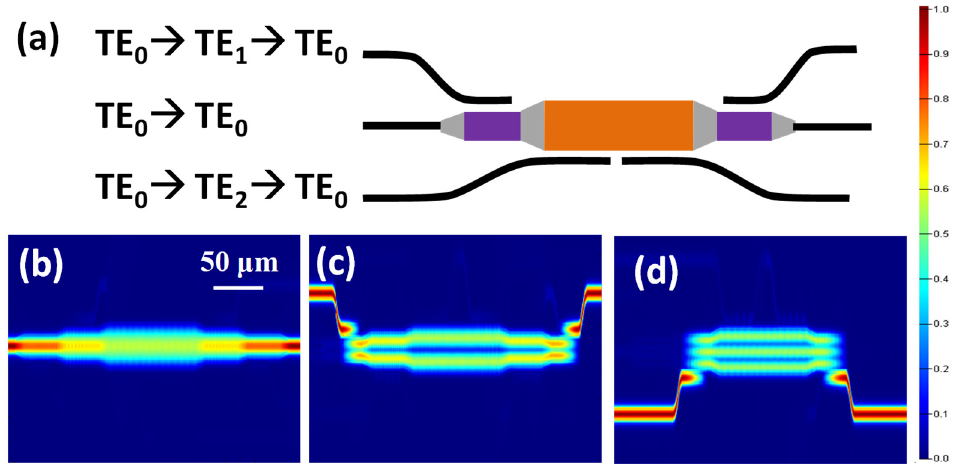
Figure 2. ( a ) Schematic of the SOI based ADC MDM Mux/Demux. FDTD simulation result of ( b ) TE 0 to TE 0 , ( c ) TE 0 to TE 1 and then back to TE 0 , ( d ) TE 0 to TE 2 and then back to TE 0